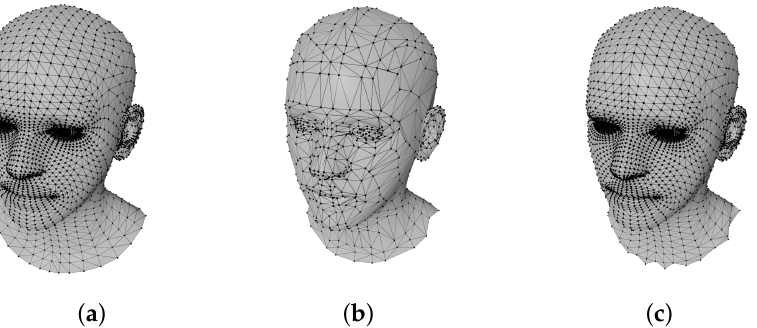
Figure 2. Mesh down- and upsampling results. The facial mesh ( a ) is downsampled for the pooling operation ( b ), then it is upsampled for the unpooling operation ( c